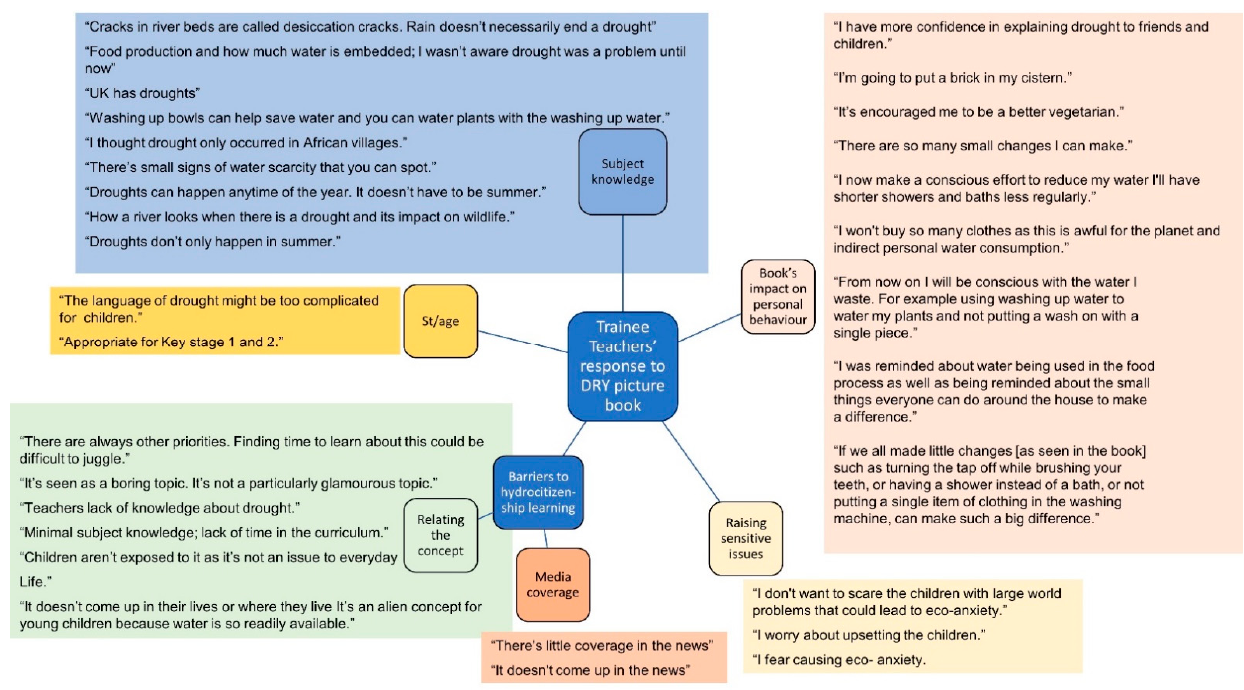
Figure 3. Trainee teacher responses to the DRY picture book.